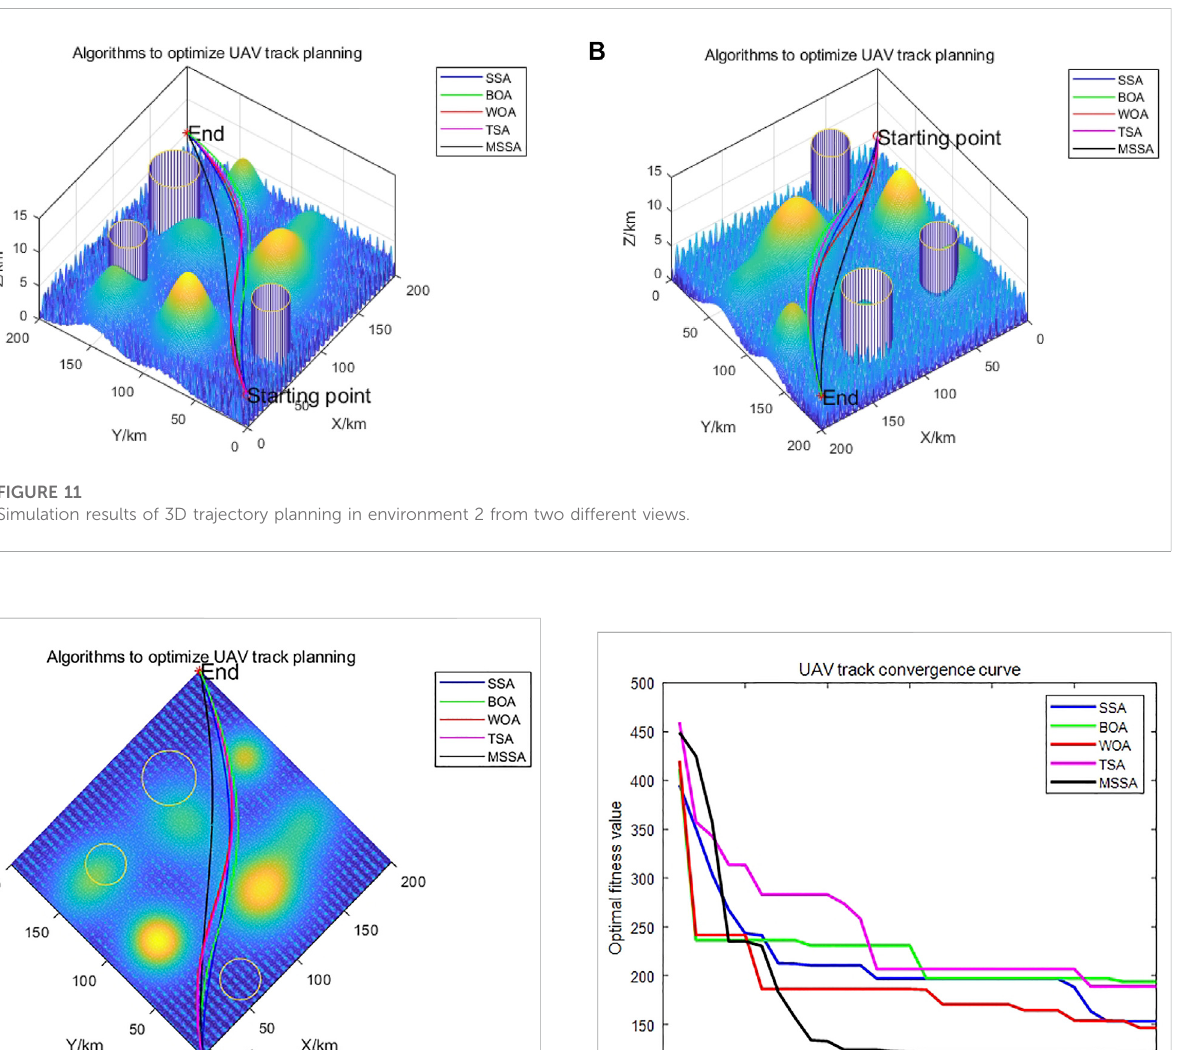
FIGURE 12 Comparison of 2D track planning in environment 2.